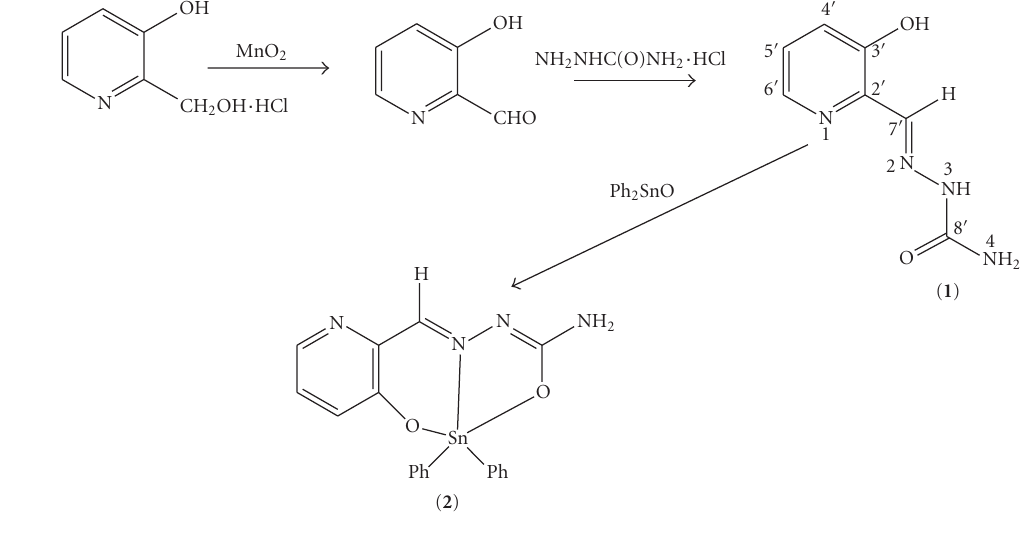
Scheme 1: The reaction scheme for synthesis of 1 and 2.